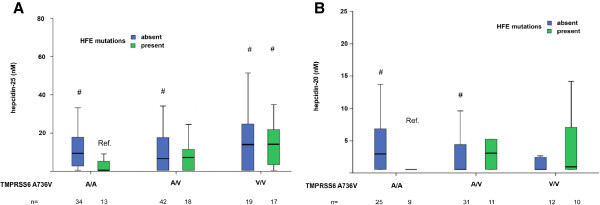
Combined effect of HFE C282Y and H63D and TMPRSS6 rs855791 (A736V) polymorphisms on hepcidin-25 levels in 143 (panel A), and on hepcidin-20 in 99 (panel B) CHD patients from Northern Italy. # p < 0.05 vs. TMPRSS6 A/A and HFE mutations present.